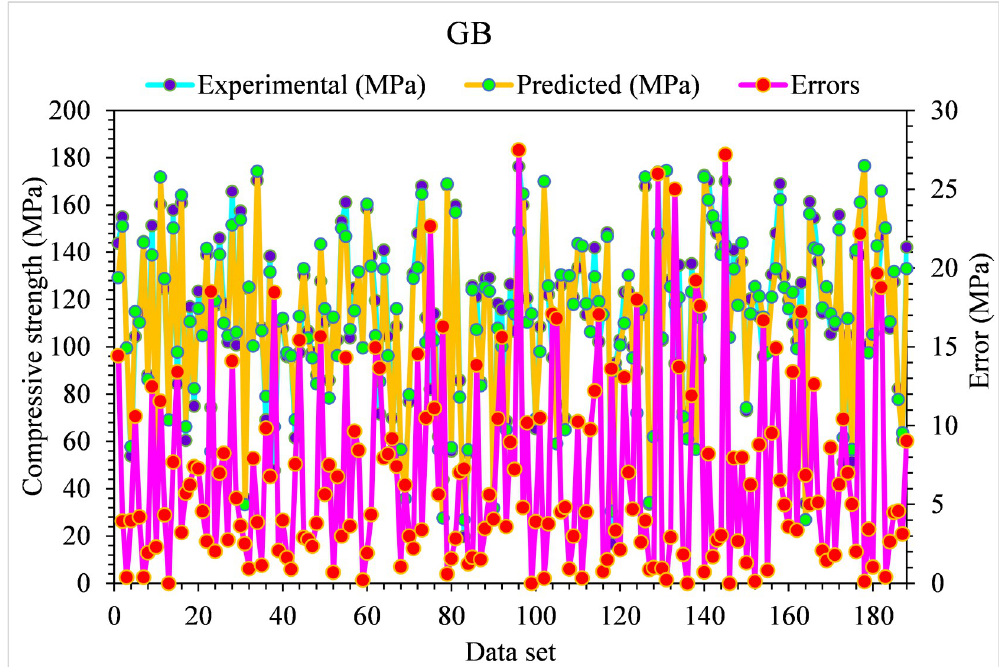
Fig 11. GB predicted and experimental error values–UHPC compressive strength.